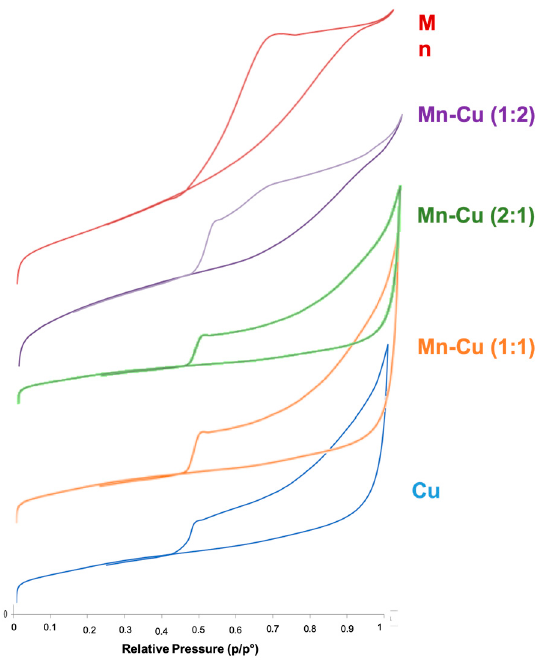
Figure 2. Nitrogen adsorption/desorption isotherms for catalyst.